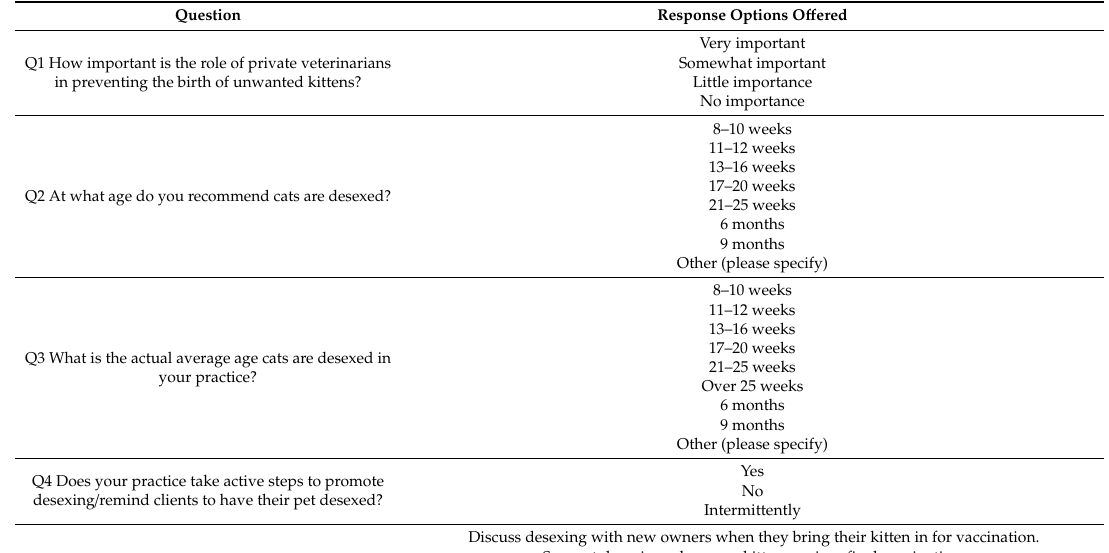
Table A1. AVA / RSPCA collaboration desexing